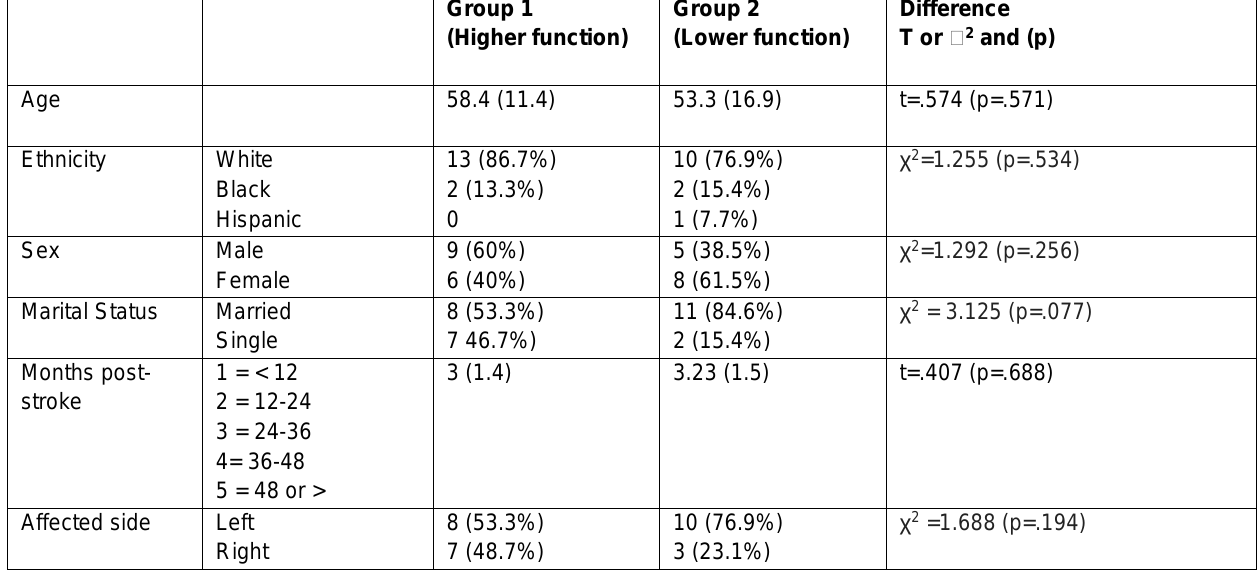
Table 1. Participant